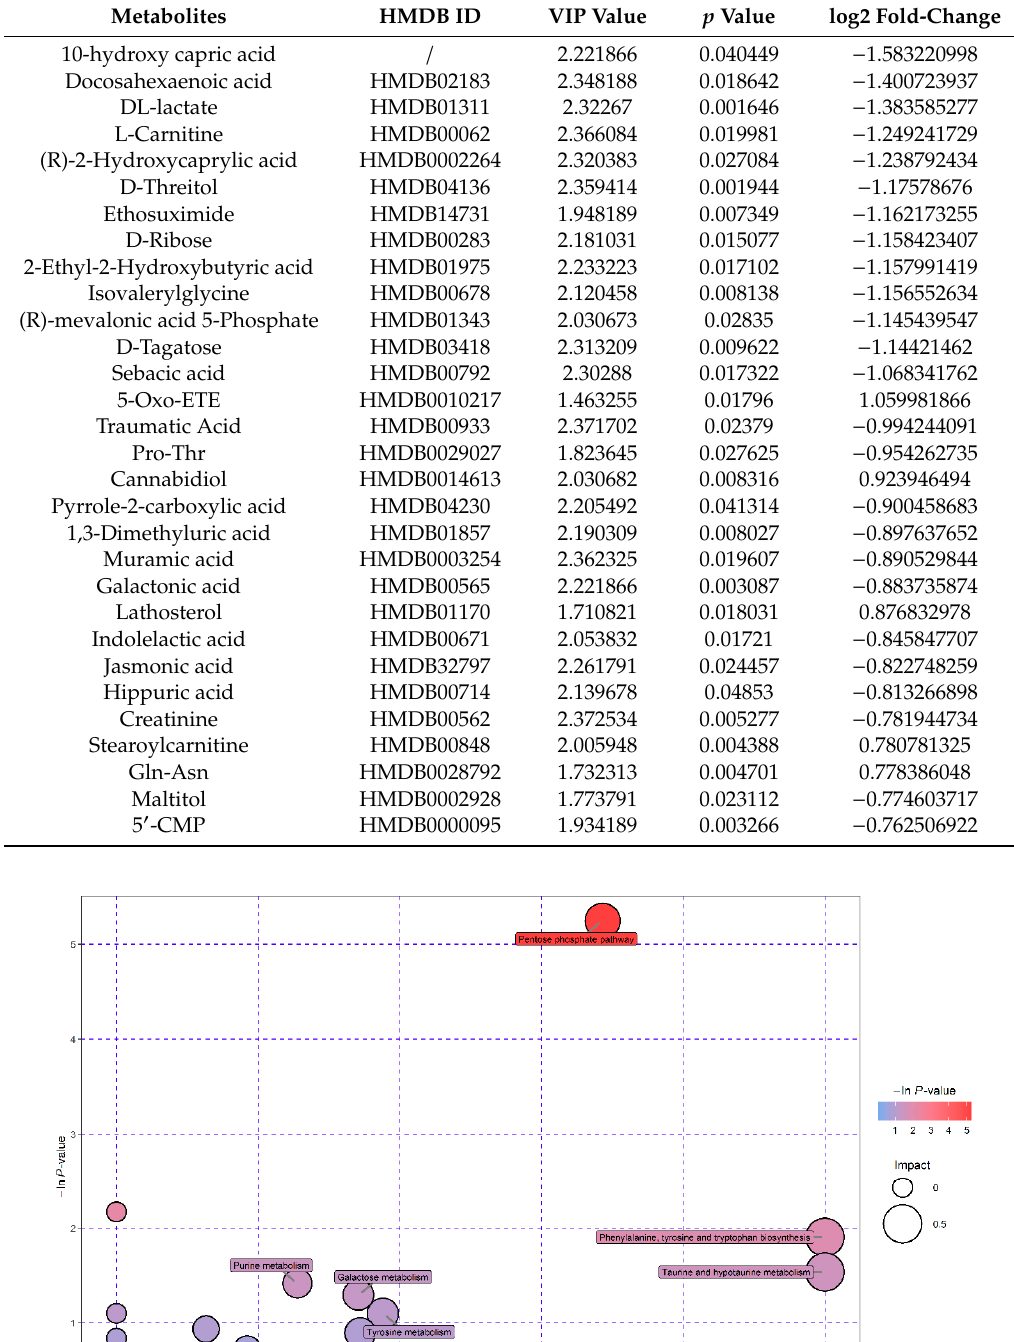
Table 1. A list of 30 significant di ff erential metabolites with the highest fold di ff erence in guts between A. apis -infected larvae and controls with VIP > 1 and p < 0.05.